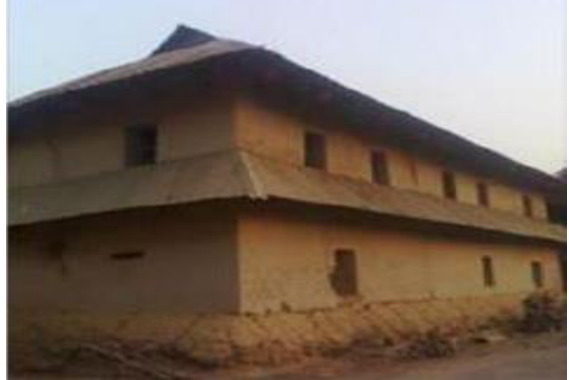
Figure 1: Two-story mud house in Manda,